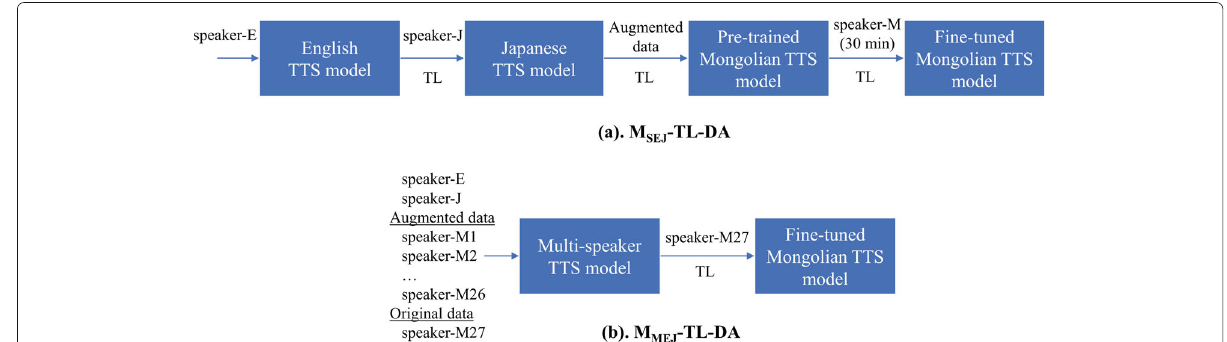
Fig. 7 Methods used to train TTS models using cross-lingual transfer learning and augmented data, where a is a single-speaker model and b is a multi-speaker model